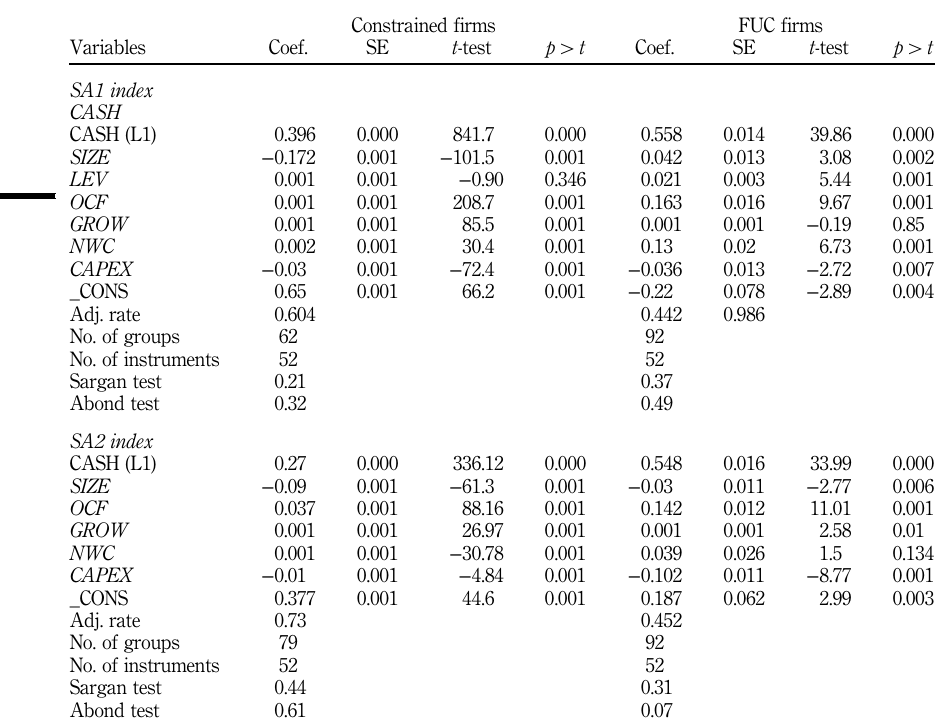
Table VIII. SA index ’ s regression results for FC and FUC firms